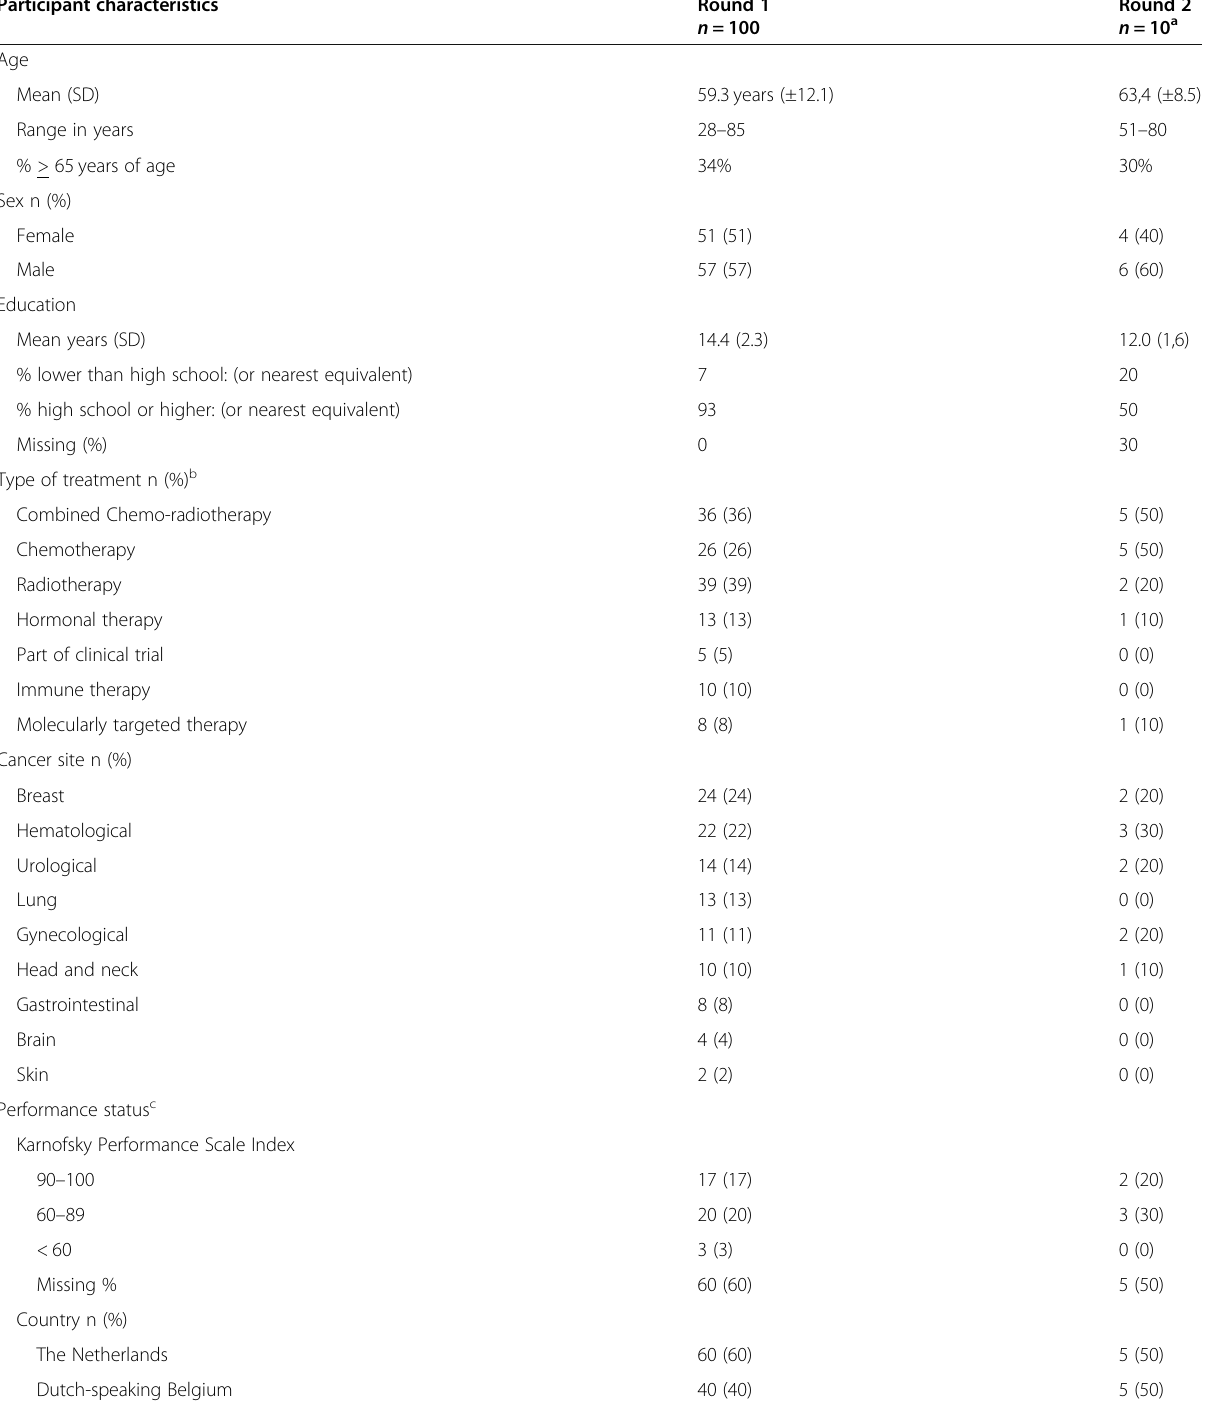
Table 1 Demographic and clinical characteristics Round 1( n = 100) and Round 2 ( n =